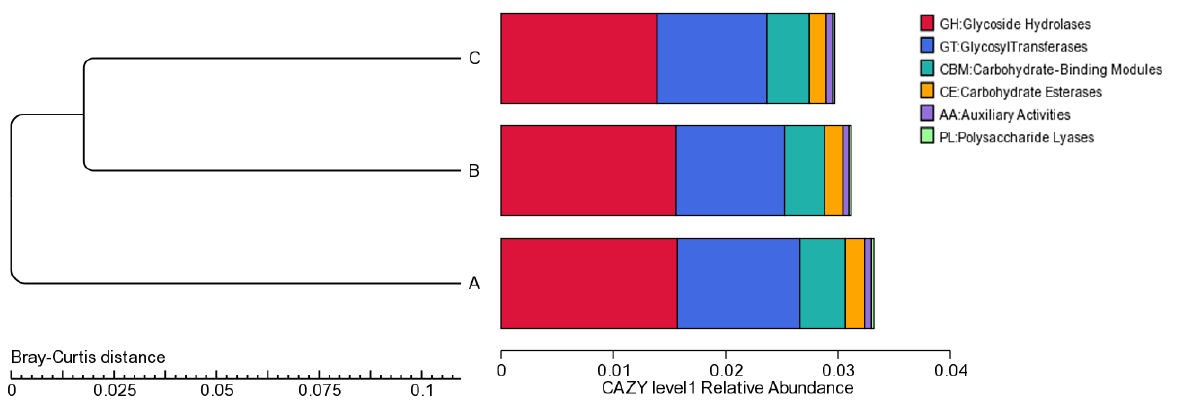
Figure 2. Composition of CAZyme-encoding genes. The cluster tree is based on the Bray – Curtis distance of CAZy relative abundance.